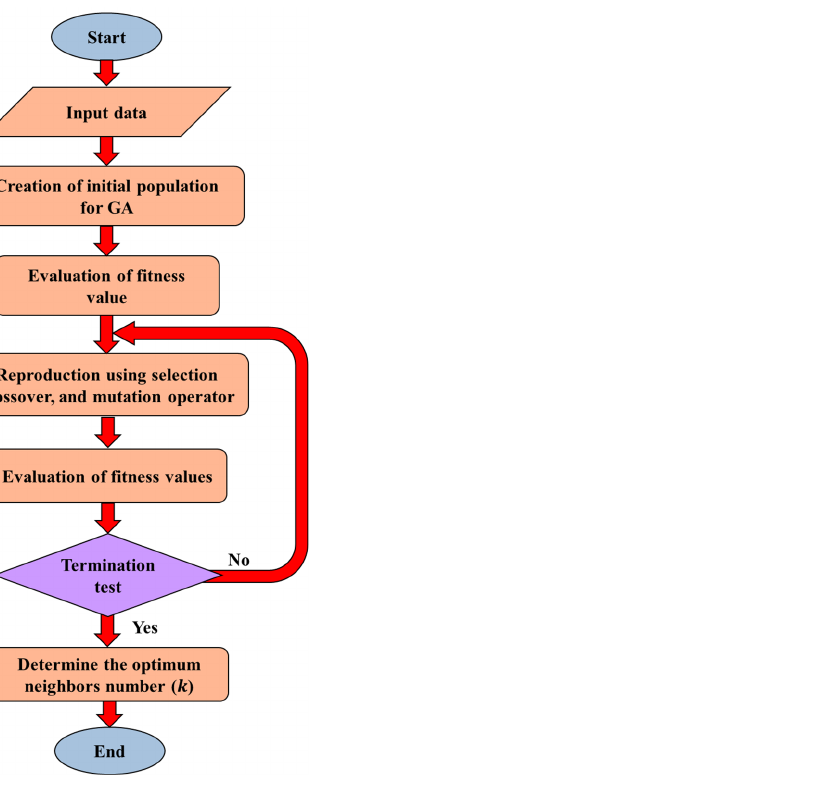
Figure 15. Flowchart of the proposed genetic algorithm (GA) for selecting the optimum k . Table 4. k-NN internal parameters.